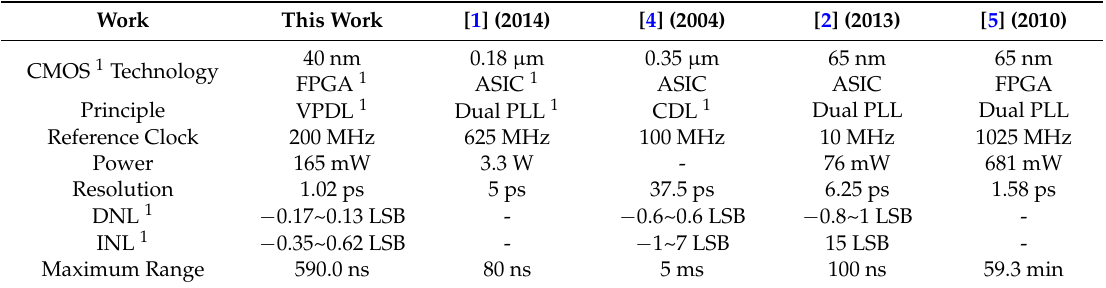
Table 1. Performance summary and comparison with pervious work.